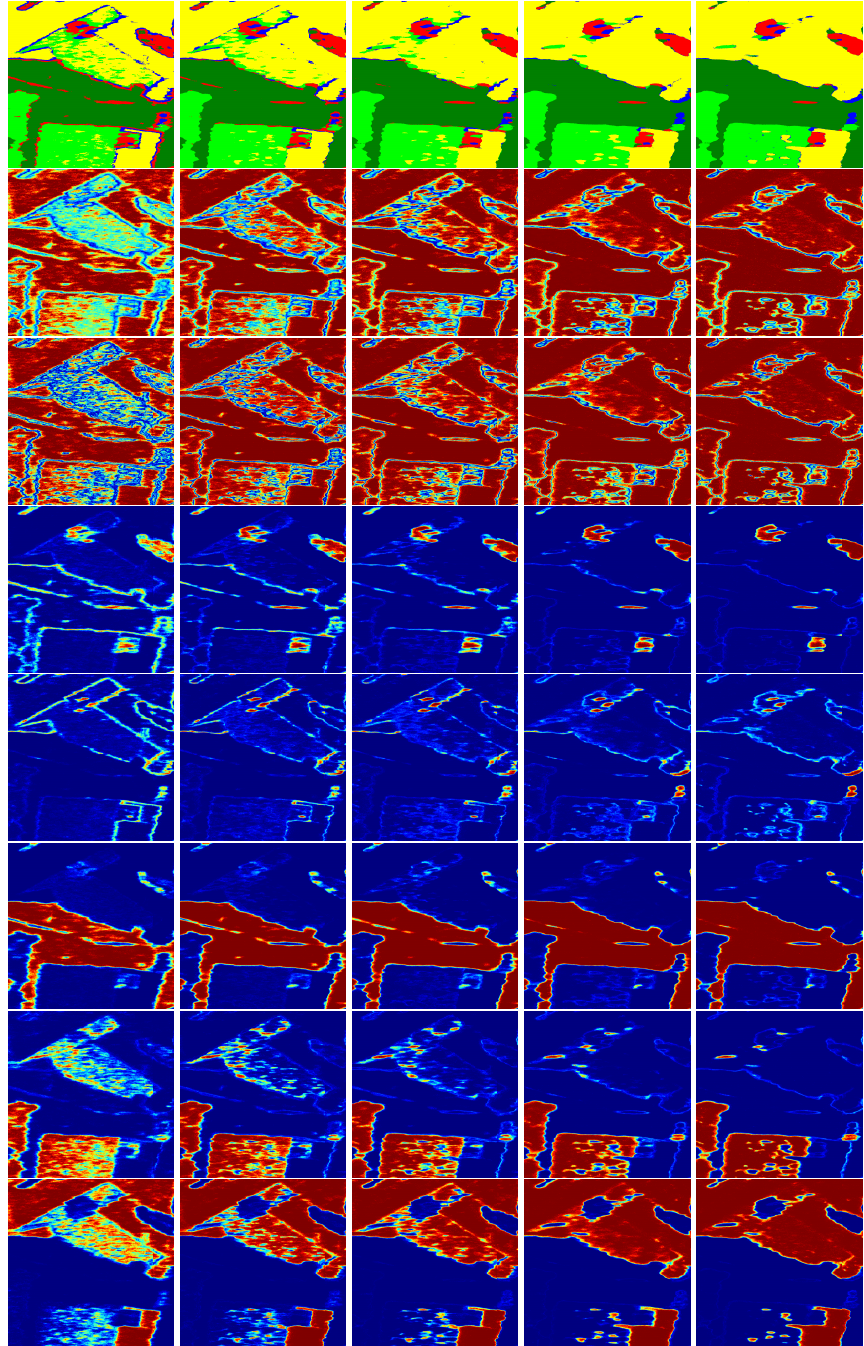
Figure 4. Detail of the Oberpfaffenhofen dataset (Image and reference data are shown in Figure 1). The columns illustrate levels 0, 1, 2, 5, and 9 of stacking. From top to bottom: label map (same color code as in Figure 3b); entropy; margin; class posterior of city, street, forest, shrubland,